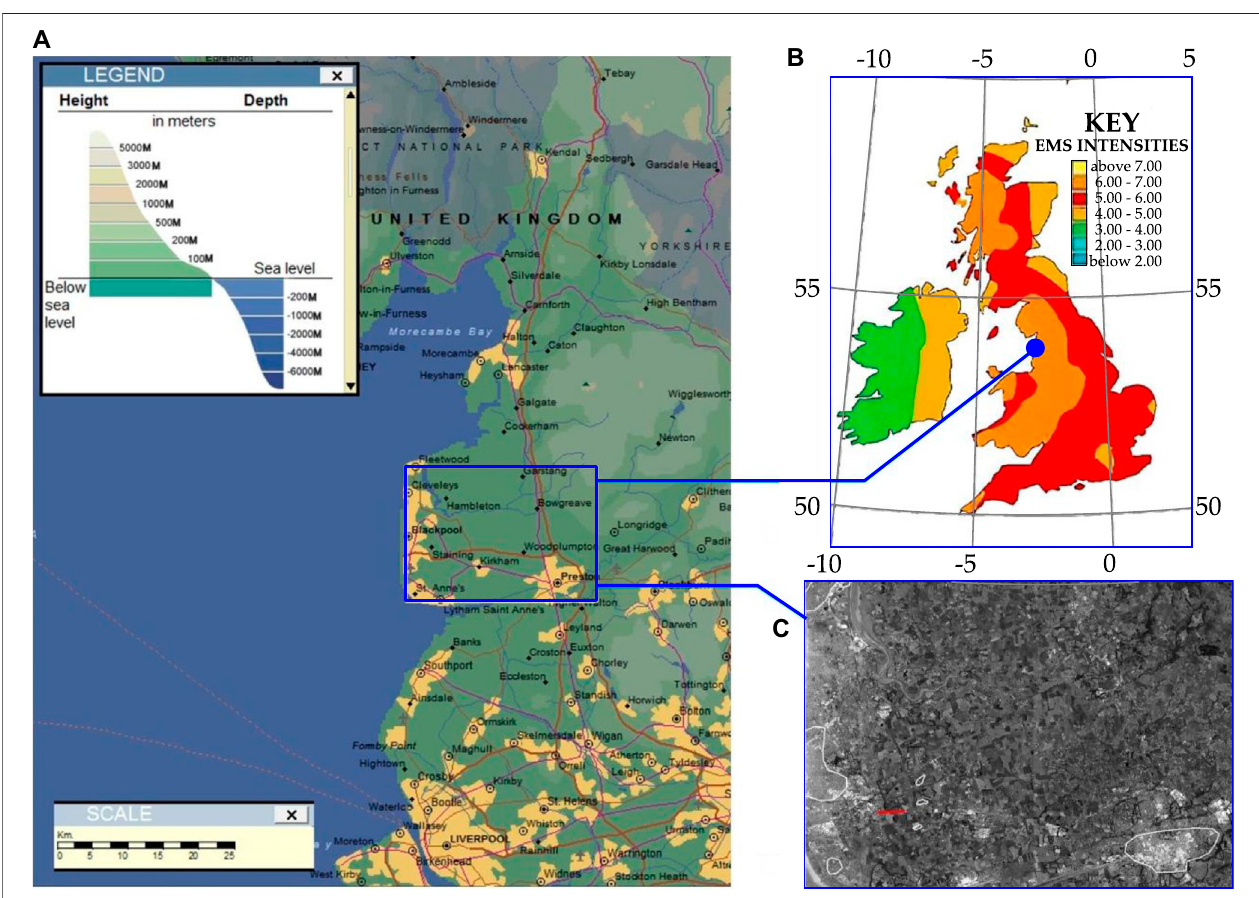
FIGURE 2 | Location of the seismic area: (A) the geographical location of the region and the relief (the region of interest is marked by the white rectangle); (B) the same region (blue rectangle) on the larger seismic zoning scheme (see British Geological Survey, 2020); (C) the areal image of the Blackpool region: white contours indicate the areas of signi fi cant seismic measurements within residential areas; red marker shows the location of the horizontal well extension, along which the hydraulic fracturing is carried out.